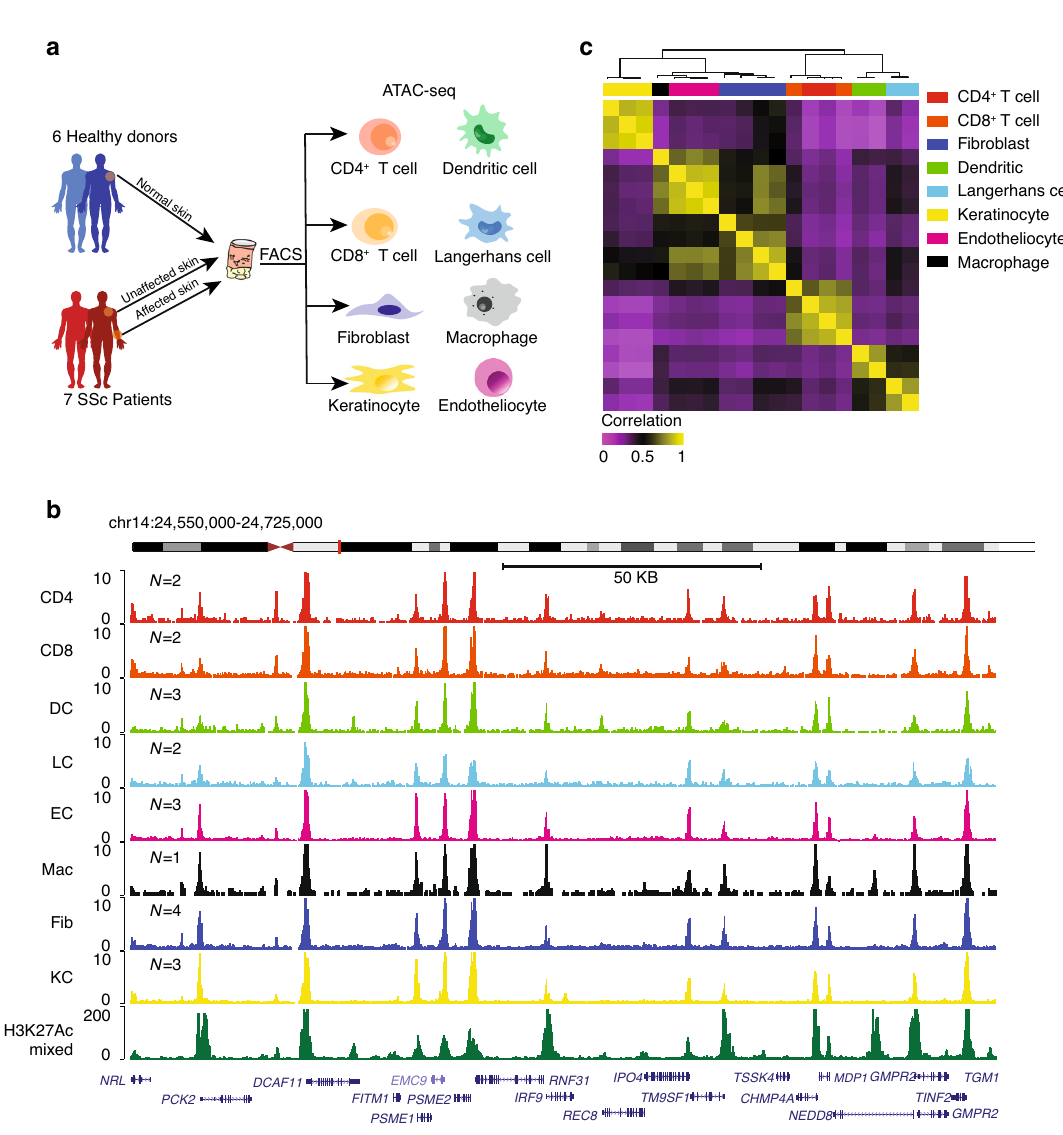
Fig. 1 Landscape of DNA accessibility in 8 cell types from normal skin in vivo. ( a ) A schematic outline of the study design depicting the work fl ow for the isolation and ATAC-seq of 8 cell types (CD4 + , CD8 + T cells (CD4, CD8), dendritic cells (DC), Langerhans cells (LC), endotheliocytes (EC), macrophages (Mac), fi broblasts (Fib), and keratinocytes (KC)) from healthy individuals (normal skin) and SSc patients (unaffected skin and affected skin). ( b ) Normalized ATAC-seq signal pro fi les at a locus in CD4, CD8, DC, LC, EC, Mac, Fib, and KC from healthy donors, shown together with a normalized H2K27ac chromatin immunoprecipitation sequencing pro fi le. N represents the number of biological replicates. ( c ) Unsupervised hierarchical clustering of the Pearson correlations between all the samples. ATAC-seq signals were obtained from distal elements. Each row and each column is a sample, and cell types distinguished colors. Source data are provided as a Source Data fi